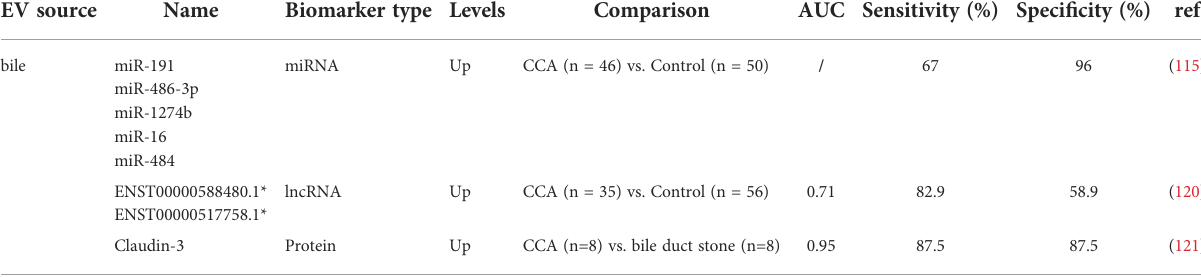
TABLE 3 Bile EVs with potential diagnostic value for